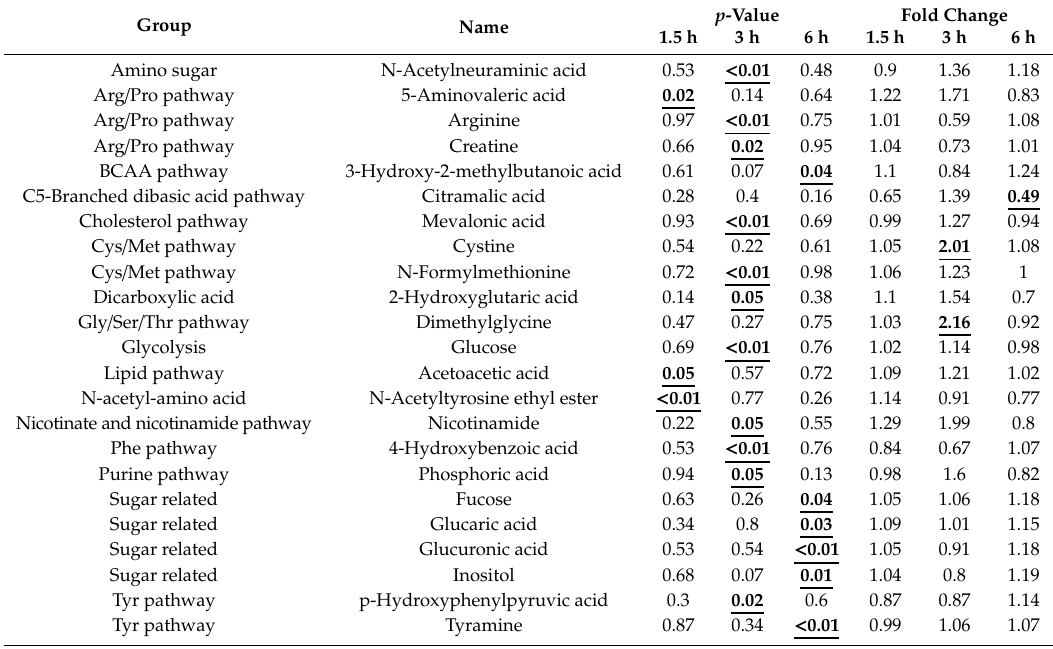
Table 1. Putative CSF hydrophilic metabolites altered by postprandial e ff